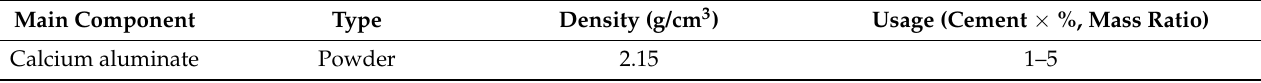
Table 2. Physical properties of hardening accelerator.